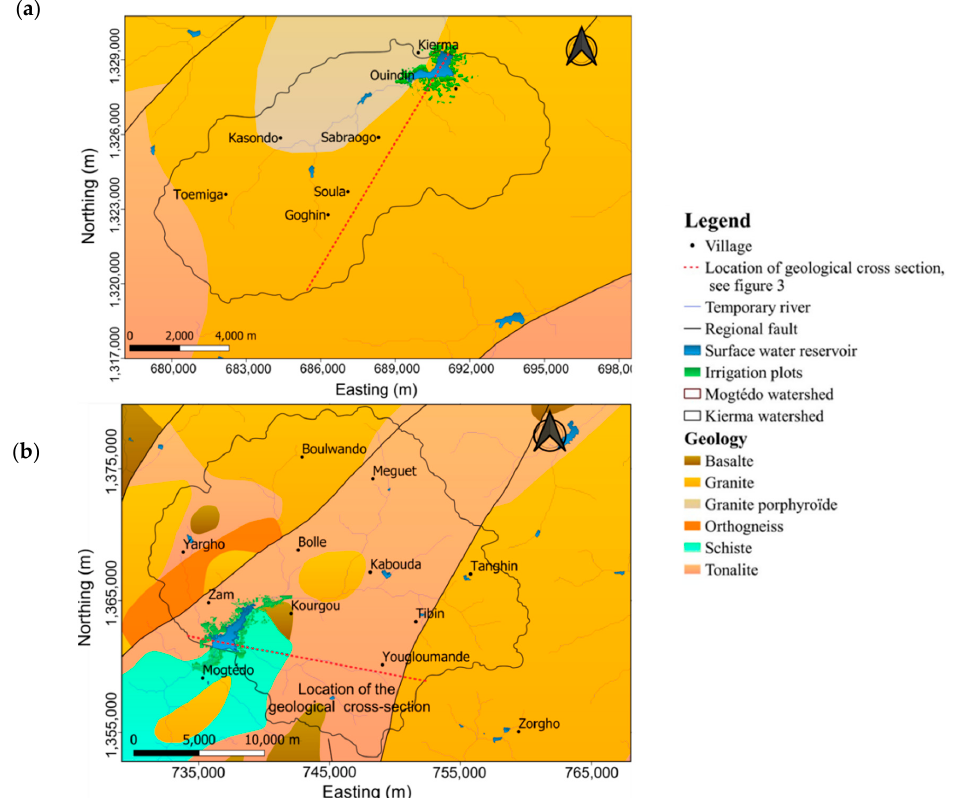
Figure 2. Geological maps of Kierma ( a ) and Mogtédo ( b ) [46].